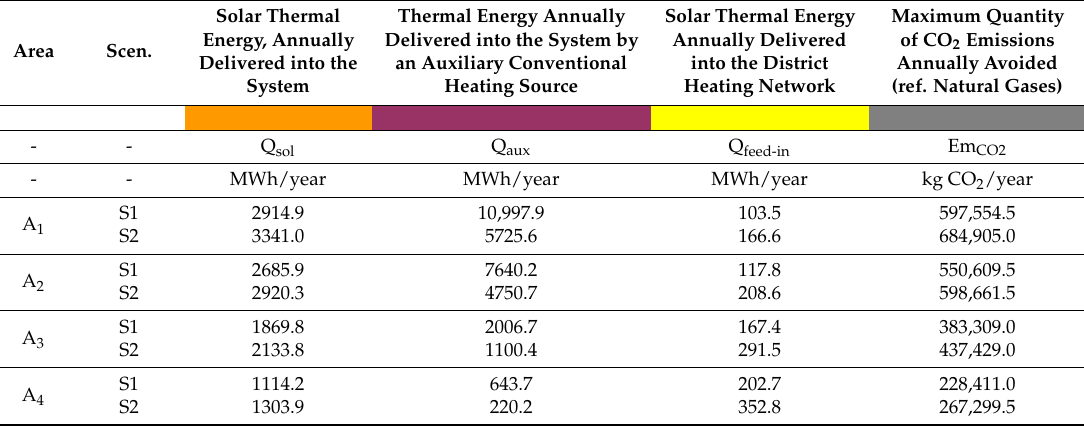
Table 10. Areas A 1 –A 4 . Indicators of thermo-energy performance.